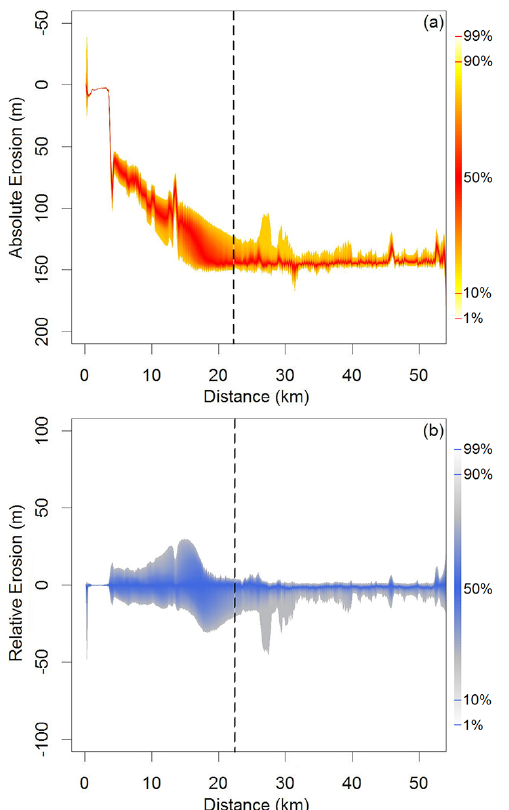
Figure 5. Simulated absolute change in coastline position (a) from 2010 to 2100 predicted using an ensemble of future wave climates. Relative change in coastline position (b) , as referenced to the base- line for each member of the ensemble. The range of colours in each plot represents the ensemble percentiles as given on the right of the figures. The black dashed line represents the divide between the northern region (to the left) and the southern region (to the right) as defined in the